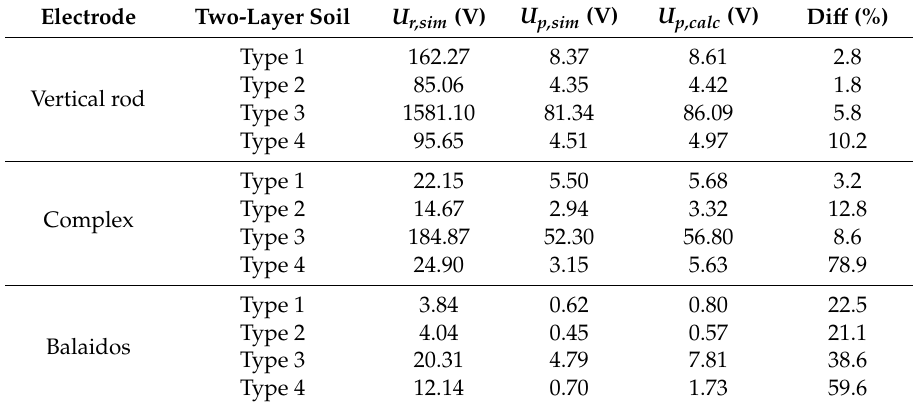
Table 1. Results of the numerical tests for validating the proposed